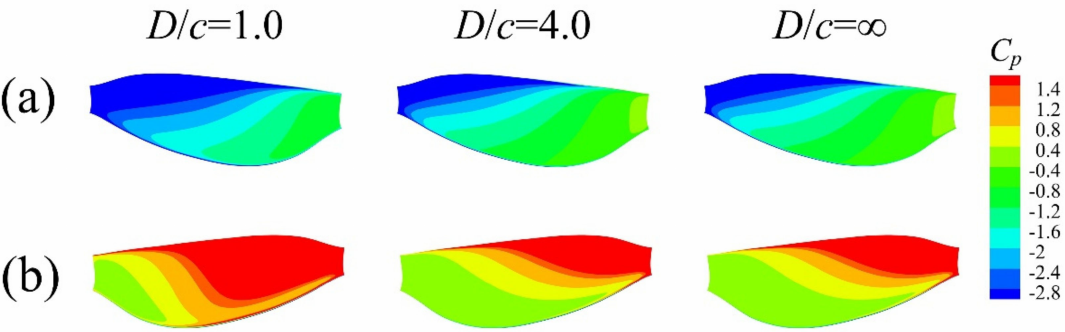
Figure 8. Surface pressure contour plots on ( a ) the upper surface and ( b ) the lower surface for D / c = 1.0, 4.0 and ∞ in the middle of the first downstroke ( τ = 0.25) at Re =